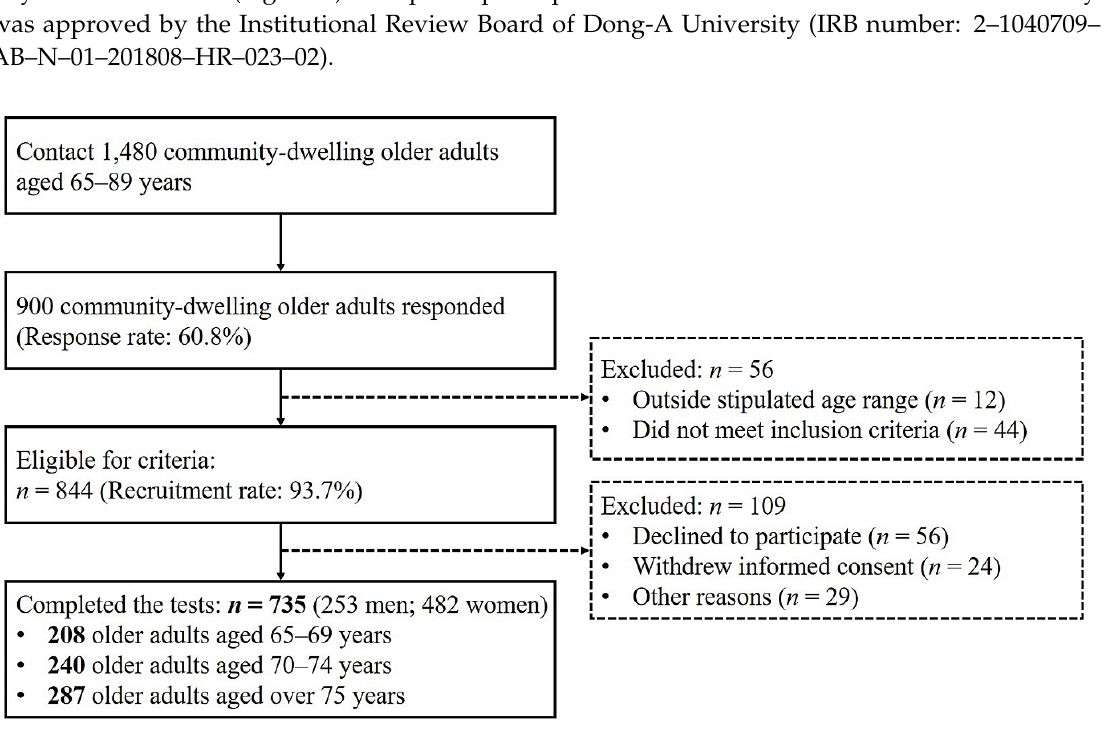
Figure 1. Flow diagram for participant recruitment.